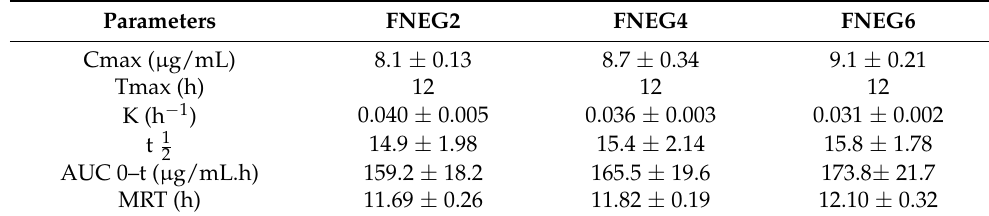
Table 6. Pharmacokinetic parameters of methotrexate from methotrexate-loaded nanoemulsion gel formulations upon administration to skin in rabbits up to 24 h. Parameters FNEG2 FNEG4 FNEG6 Cmax ( µ g/mL) 8.1 ± 0.13 8.7 ± 0.34 9.1 ± 0.21 Tmax (h) 12 12 12 K (h − 1 ) 0.040 ± 0.005 0.036 ± 0.003 0.031 ± 0.002 14.9 ± 1.98 15.4 ± 2.14 15.8 ± 1.78 t 1 2 AUC 0–t ( µ g/mL.h) 159.2 ± 18.2 165.5 ± 19.6 173.8 ± 21.7 MRT (h) 11.69 ± 0.26 11.82 ± 0.19 12.10 ±